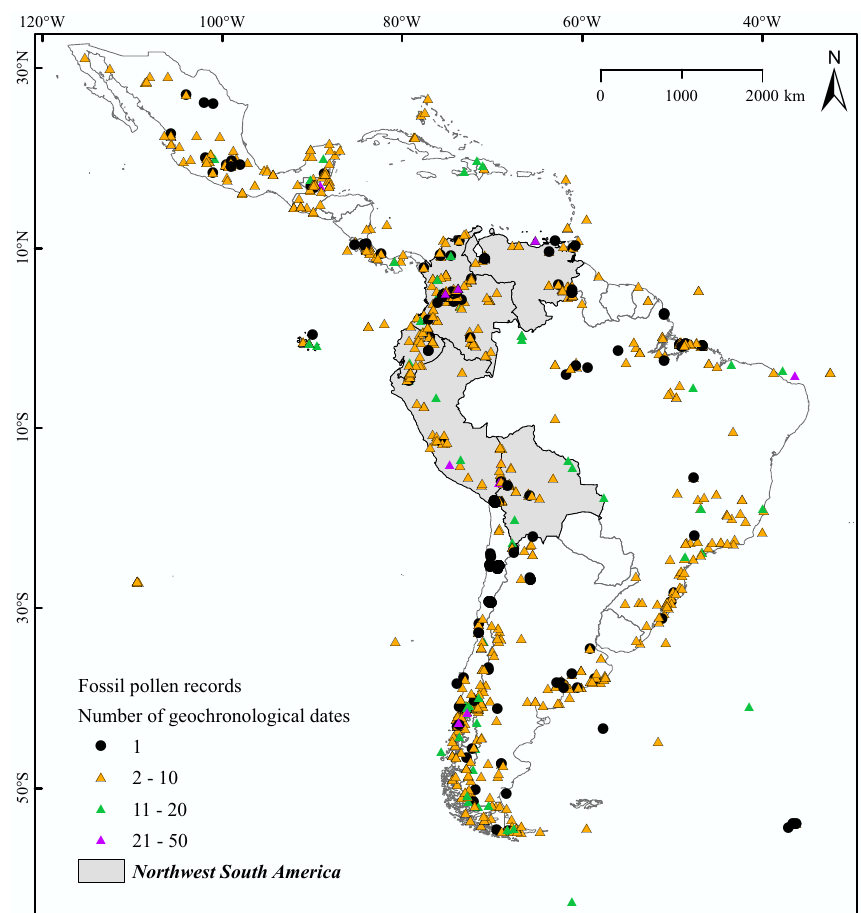
Figure 1. Pollen records currently present in the Neotropical Geochronological database. All records contain at least one geochronological